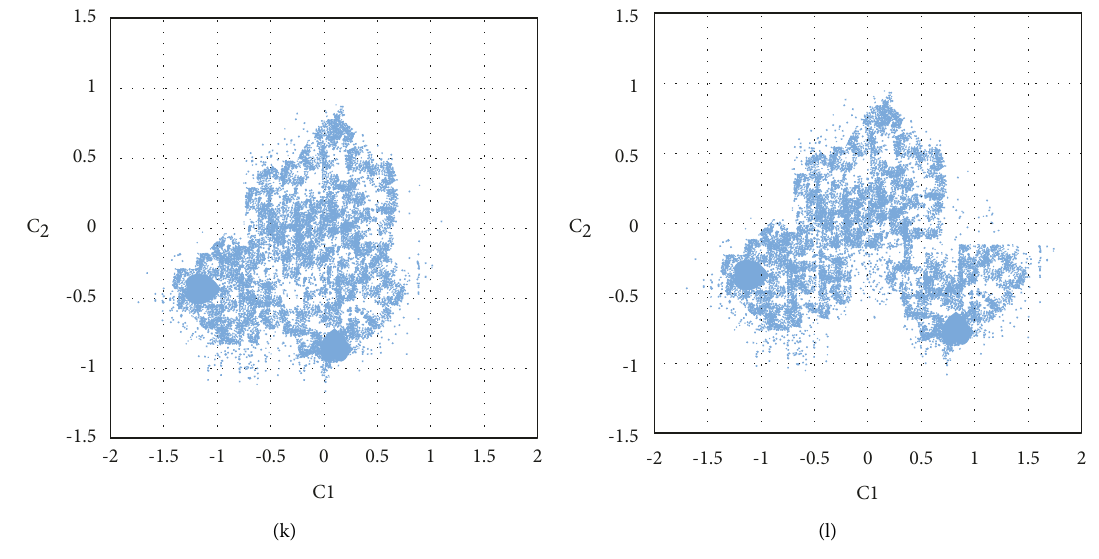
Figure 2: Mandelbrot set of noise